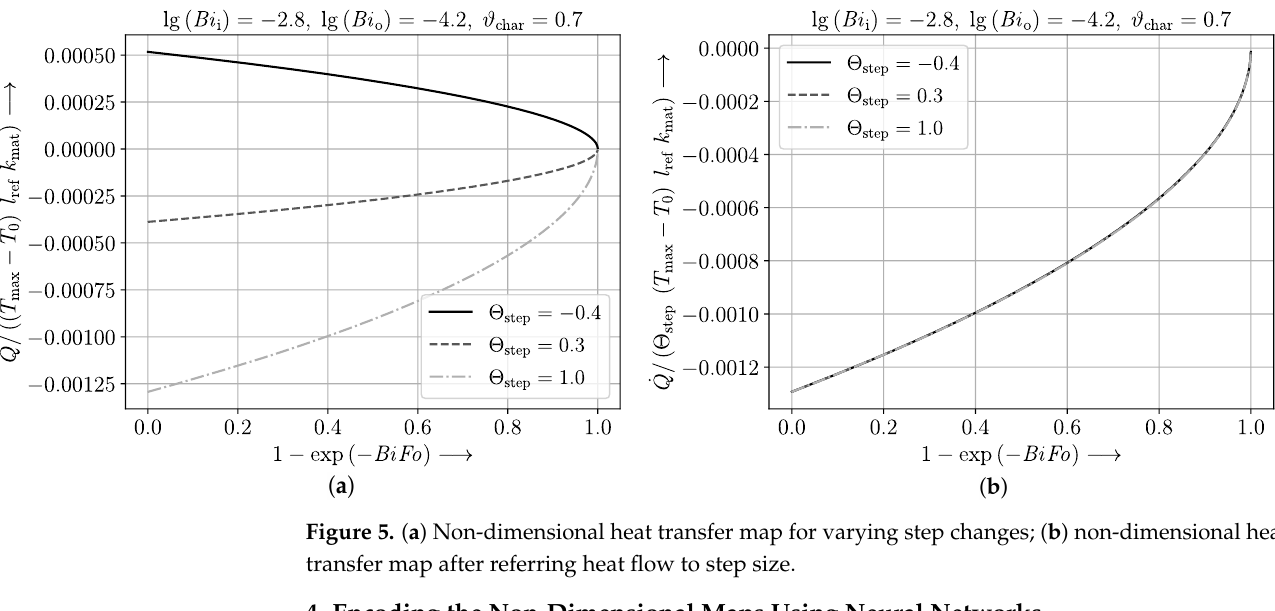
Figure 4. Non-dimensional transient heat transfer map for a given step change of Θ step = 1.